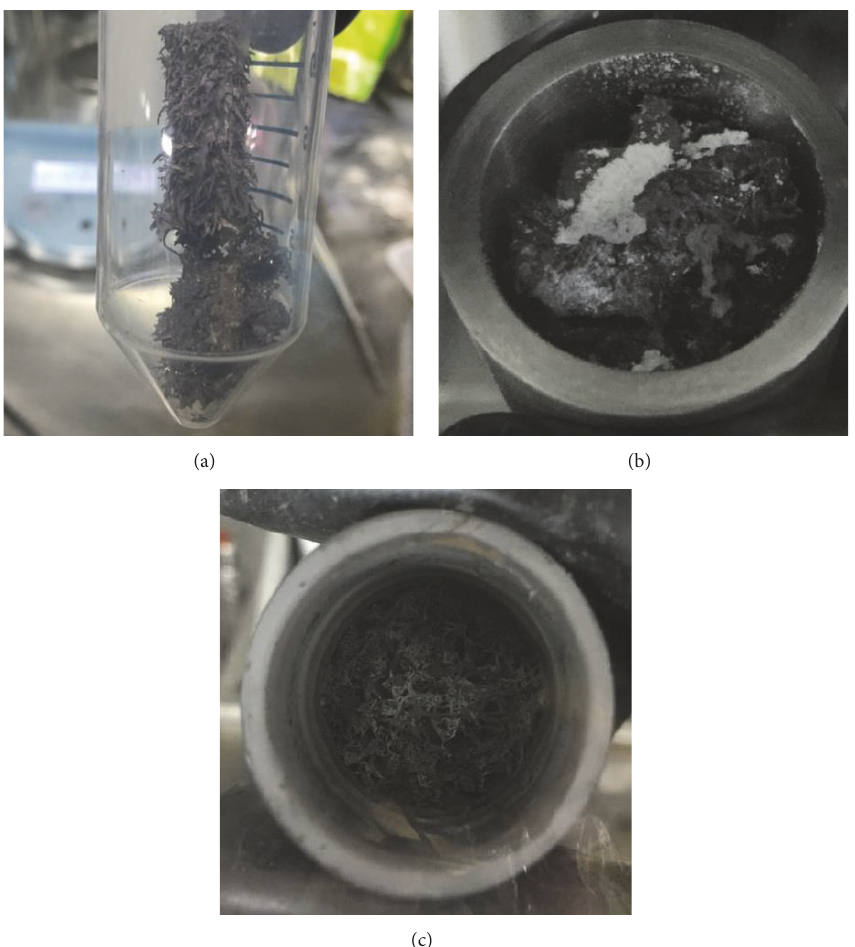
Figure 3: Images of materials (a, b) before and (c) after salt distillation test; (a) U dendrites, (b) mixture of dendrites with salts, and (c) remains.